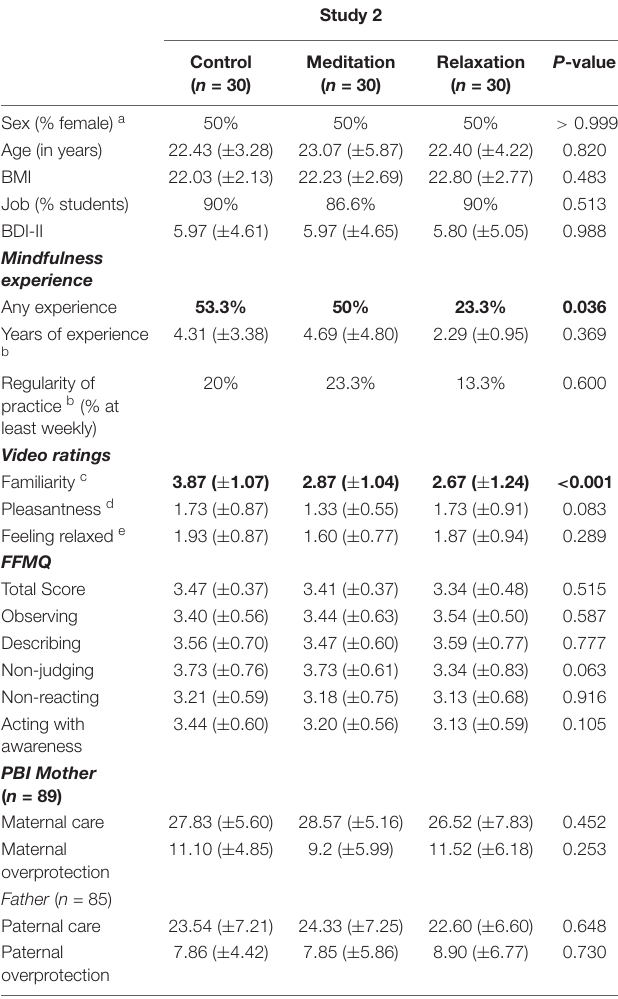
TABLE 3 | Sample characteristics and group comparison in Study